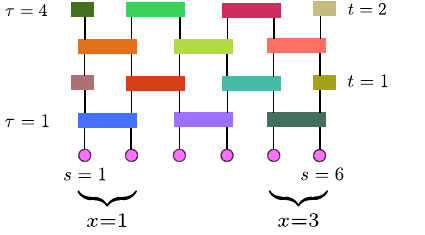
FIG. 1. Structure of the local unitary circuits studied in this paper. The on-site Hilbert space dimension is q . Each two-site gate is a q 2 × q 2 unitary matrix. For the random circuit model of Eq. (4), each gate is randomly chosen from the Haar distribution. For the Floquet models considered in Secs. IVand V, the two-site gates are defined by the Floquet unitaries in Eqs. (28) and (33), respectively.